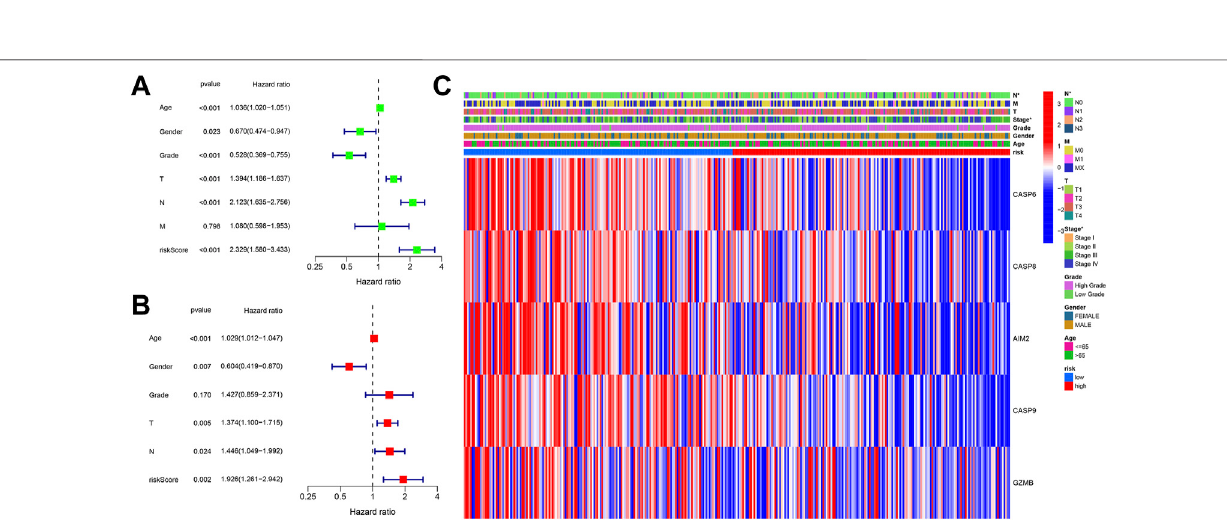
FIGURE5 |(A) Univariate Coxregression analysisofOS forclinical characteristics and riskscore. (B) MultivariateCox regression analysisofclinical characteristics and risk score. (C) Heatmap shows the connections between clinical characteristics and risk score.